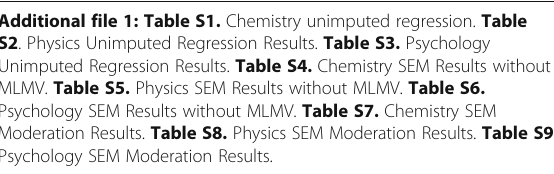
Psychology SEM Results without MLMV. Table S7. Chemistry SEM Moderation Results. Table S8. Physics SEM Moderation Results. Table S9 Psychology SEM Moderation